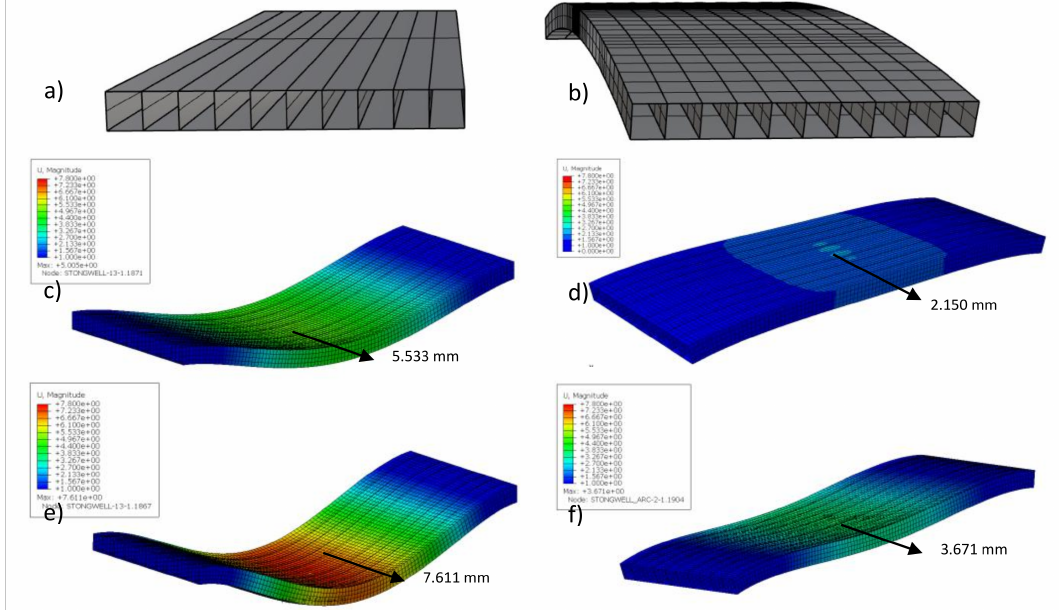
Figure 8. Geometry of: ( a ) Strongwell and ( b ) Strongwell in an arch. Deformation for: ( c ) Strongwell (laminate); ( d ) Strong- well (laminate) in an arch; ( e ) Strongwell (quasi-isotropic); ( f ) Strongwell (quasi-isotropic) in an